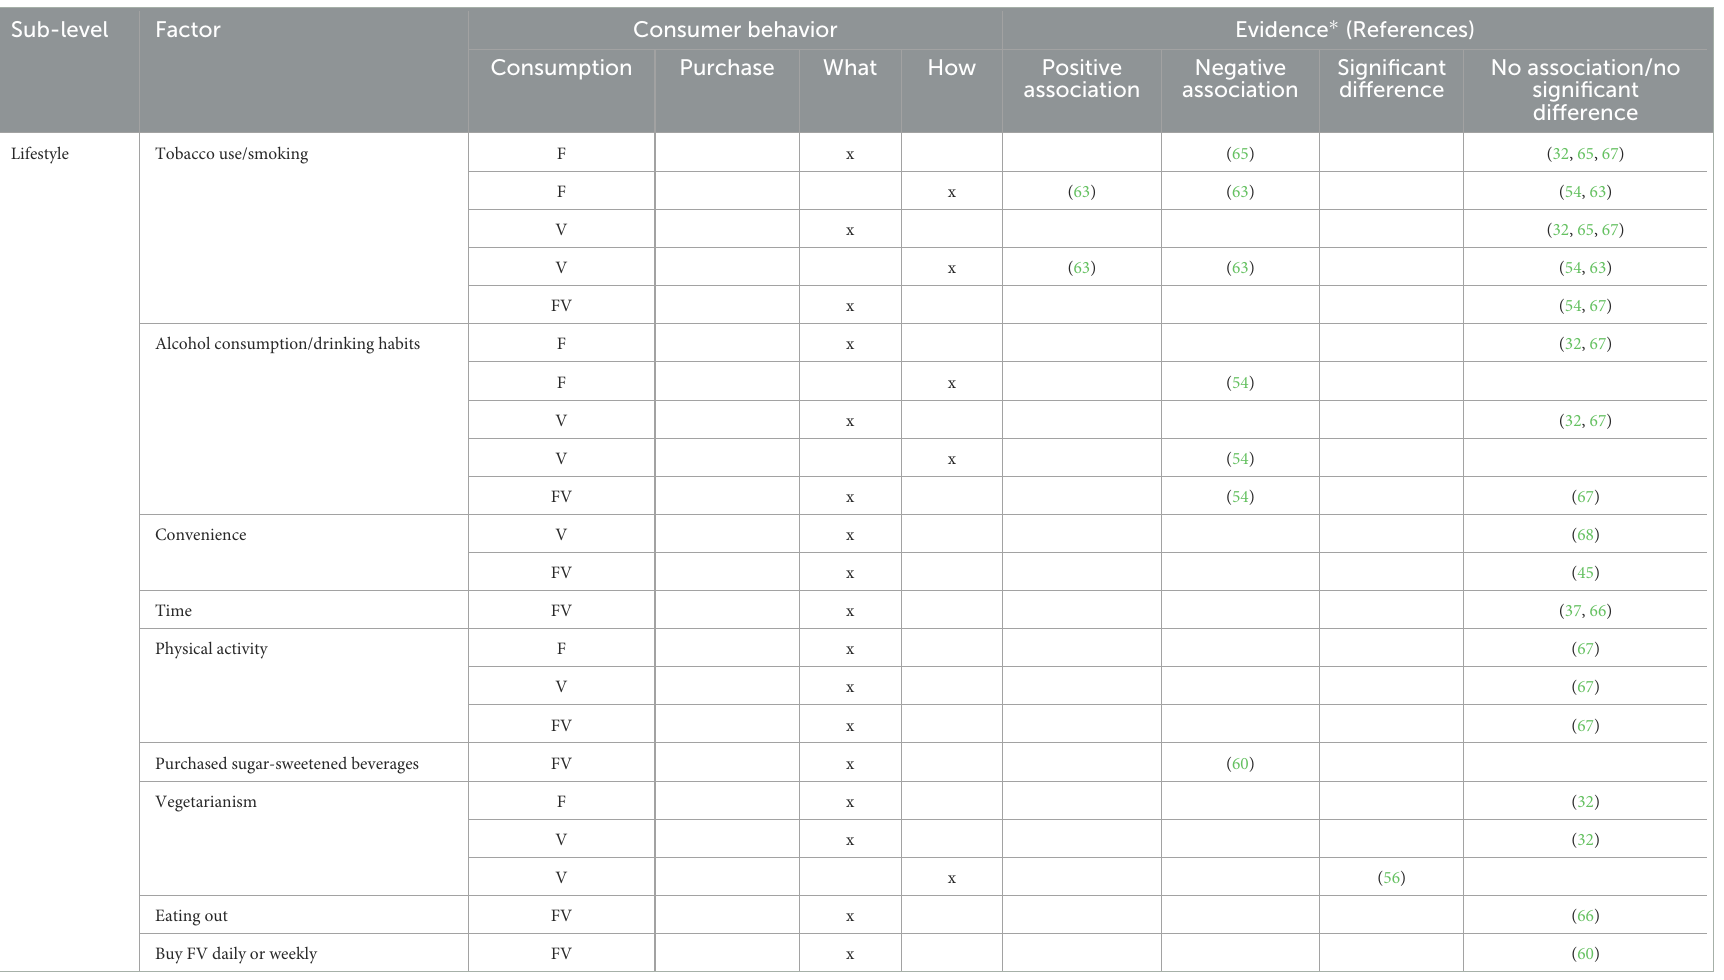
TABLE 2C Individual/household level